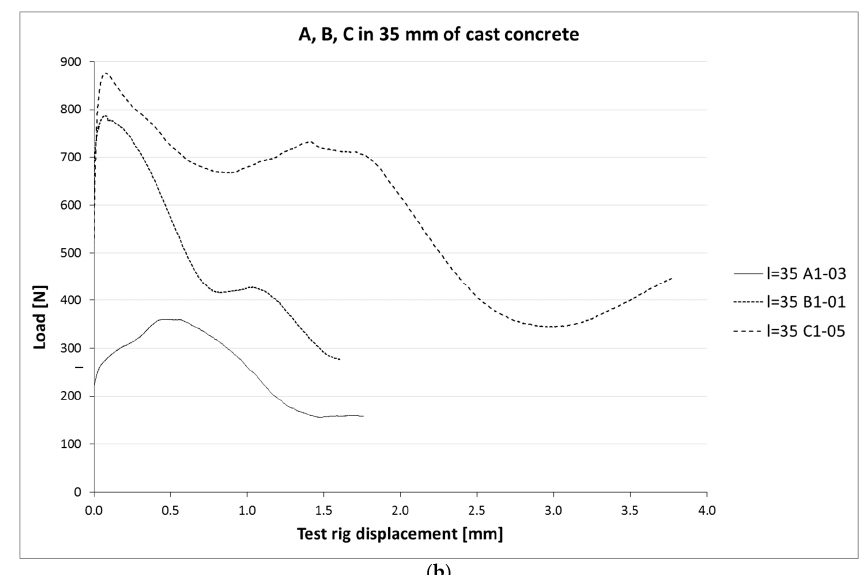
Figure 6. ( a ) Load-slip curves of pull-out tests of cast samples with l cs = 15 mm. For each series, one curve is shown (for reasons of clarity), considered representative for that particular series. It should be noted that the individual behaviour can differ significantly, as is also clear from the coefficients of variation. ( b ) Load-slip curves of pull-out tests of representative cast samples with l cs = 35 mm.